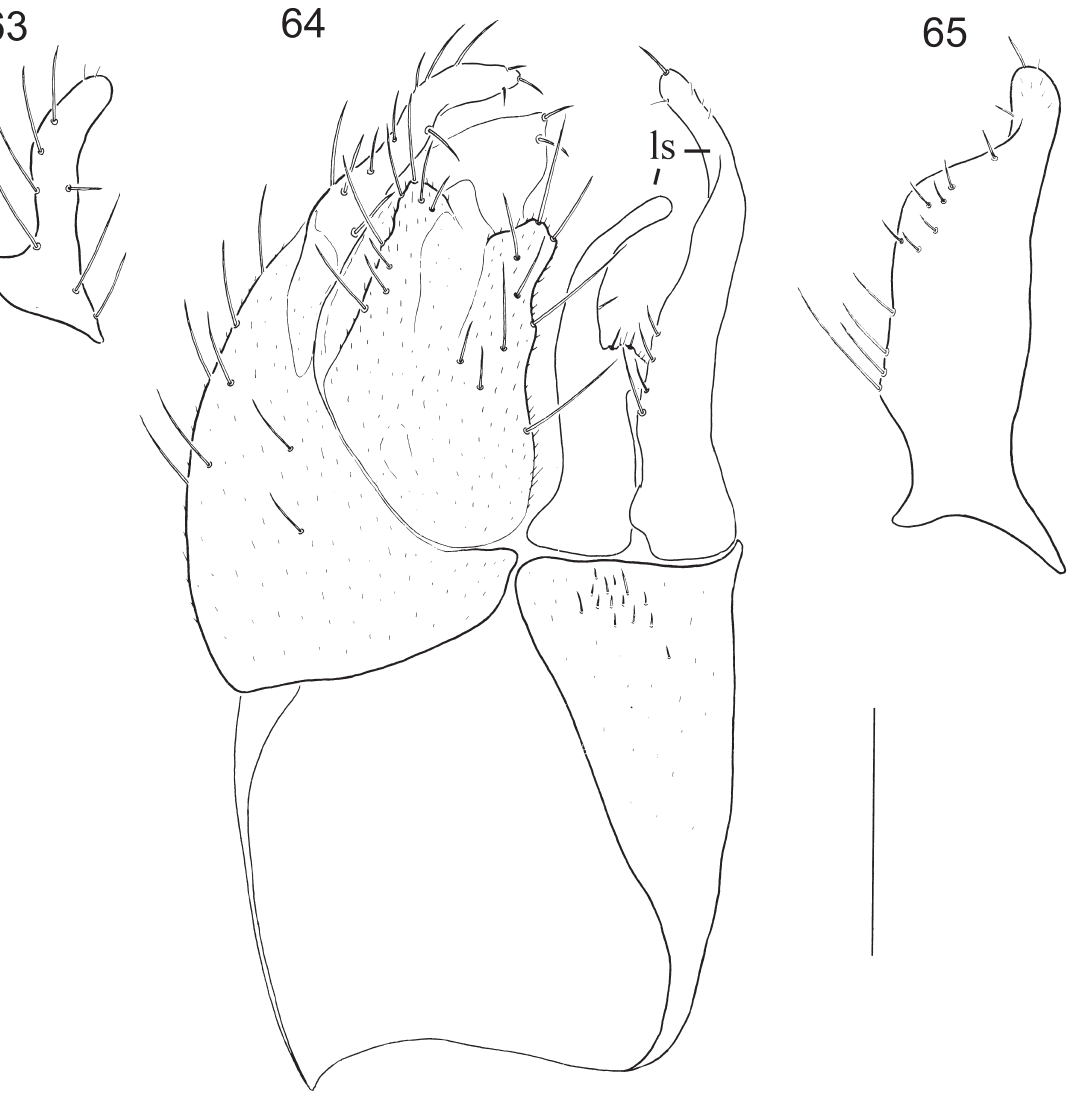
Figs 63-65. Chersodromia pasir sp. nov., ♂ terminalia. 63 . right surstylus, dorsal view. 64 . epandrium and cerci, dorsal view. 65 . left surstylus, lateral view. Scale bar = 0.1